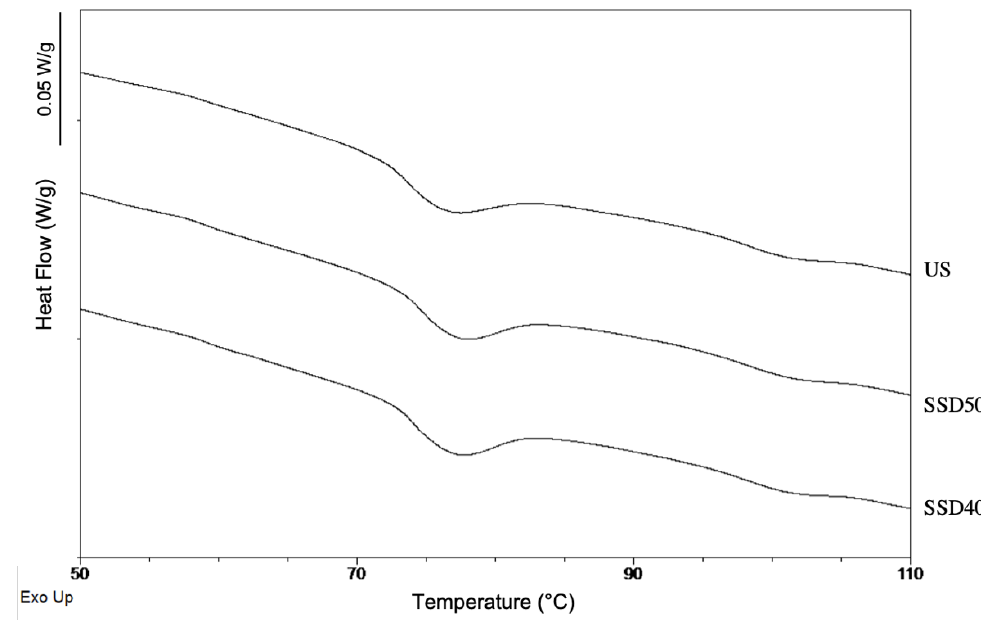
Figure 3. Representative differential scanning calorimeter (DSC) thermograms of US, SSD50 and SSD40 flours in the range 50–110 °C. US, unsprouted sorghum flour; SSD50, flour from sprouted sorghum dried at 50 °C for 6 h; SSD40, flour from sprouted sorghum dried at 40 °C for 12 h.